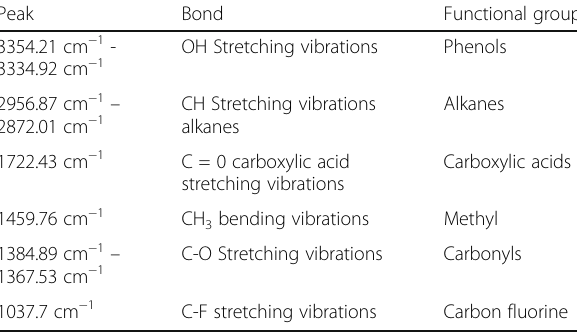
Alkanes Carboxylic acids Carbonyls